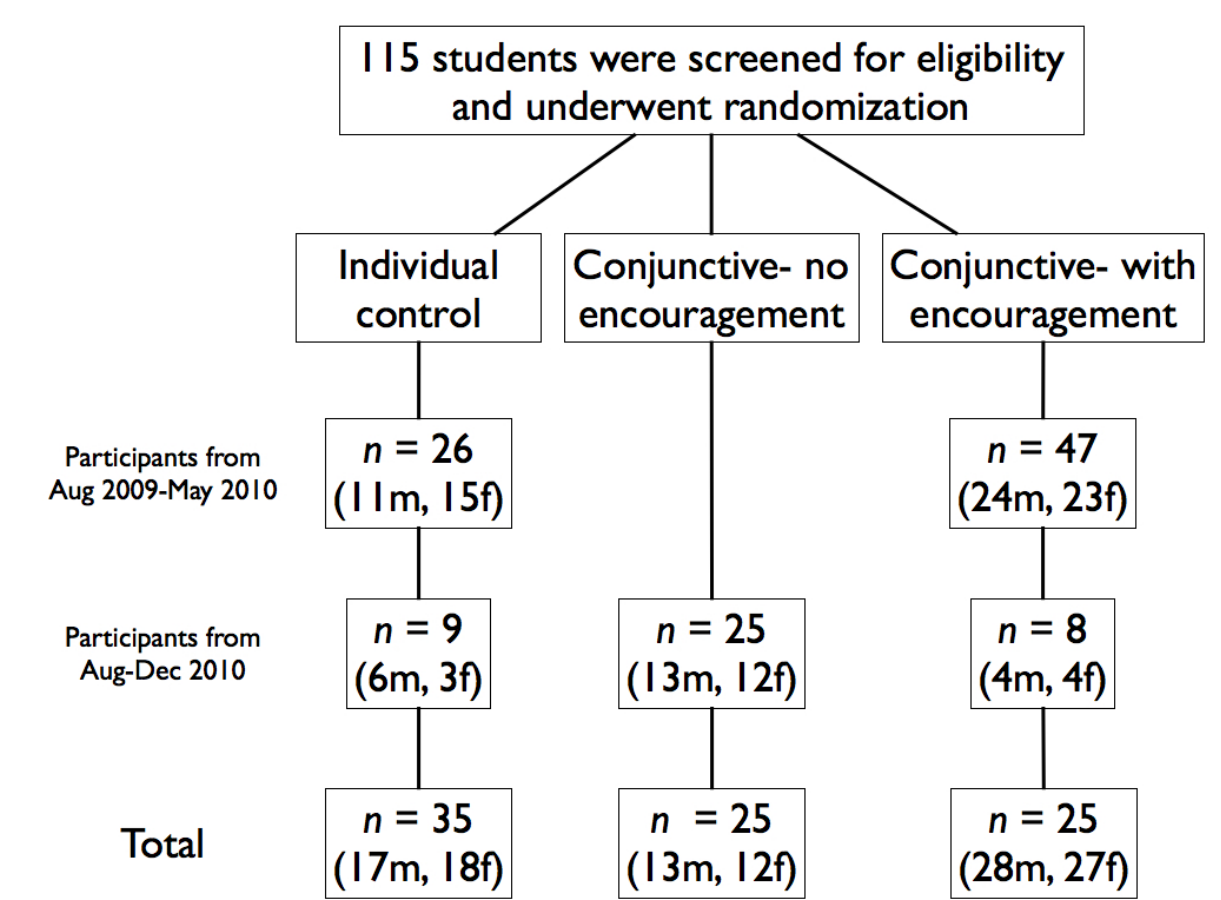
Figure 1. Participant